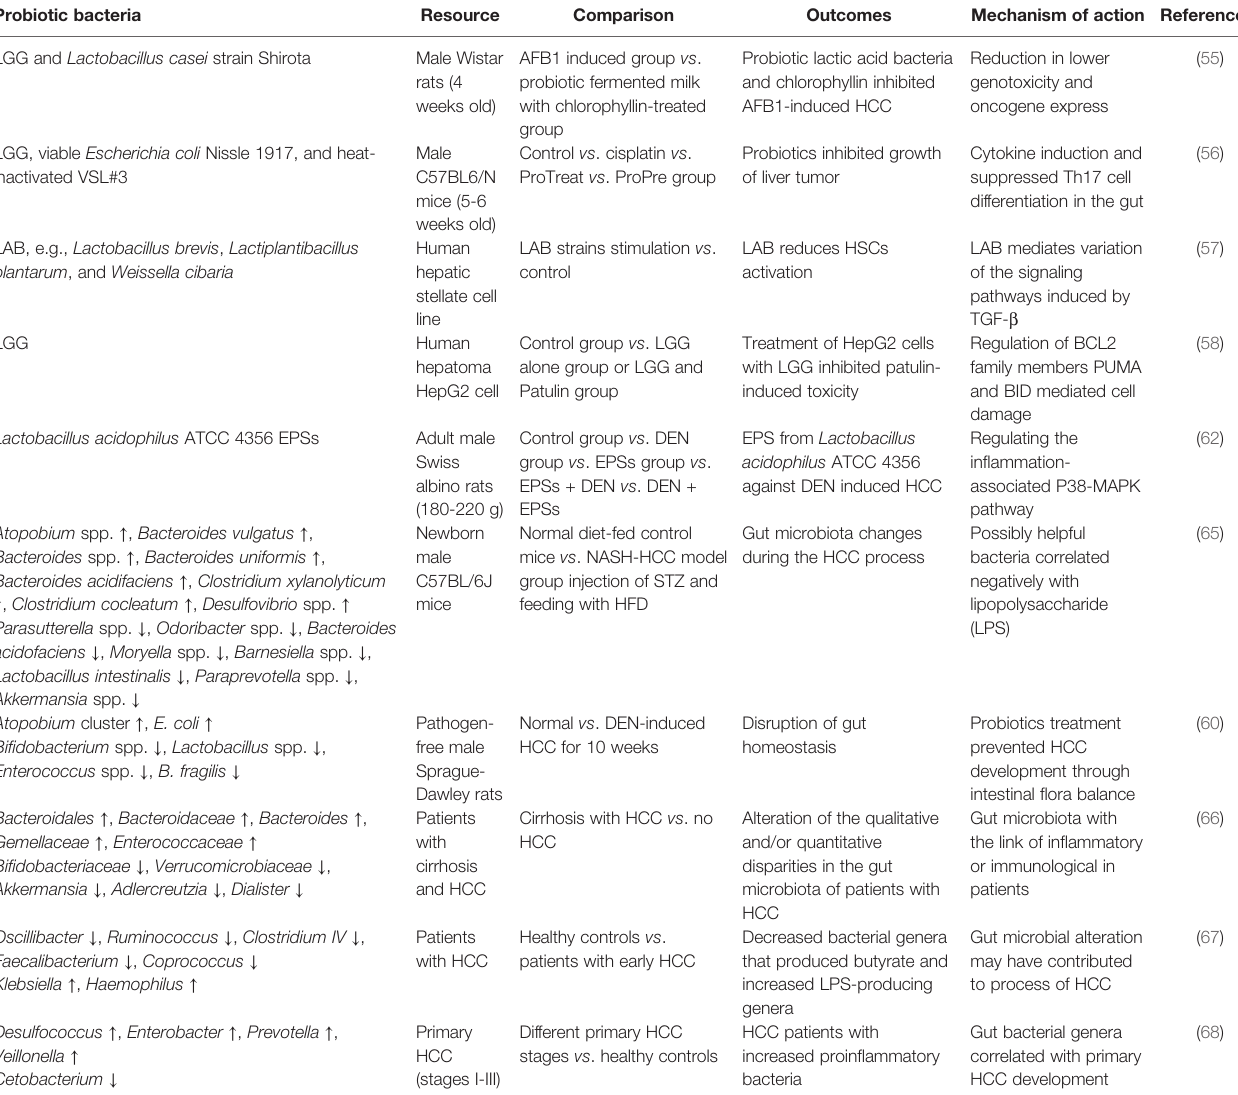
TABLE 2 | Summary of the probiotics associated with